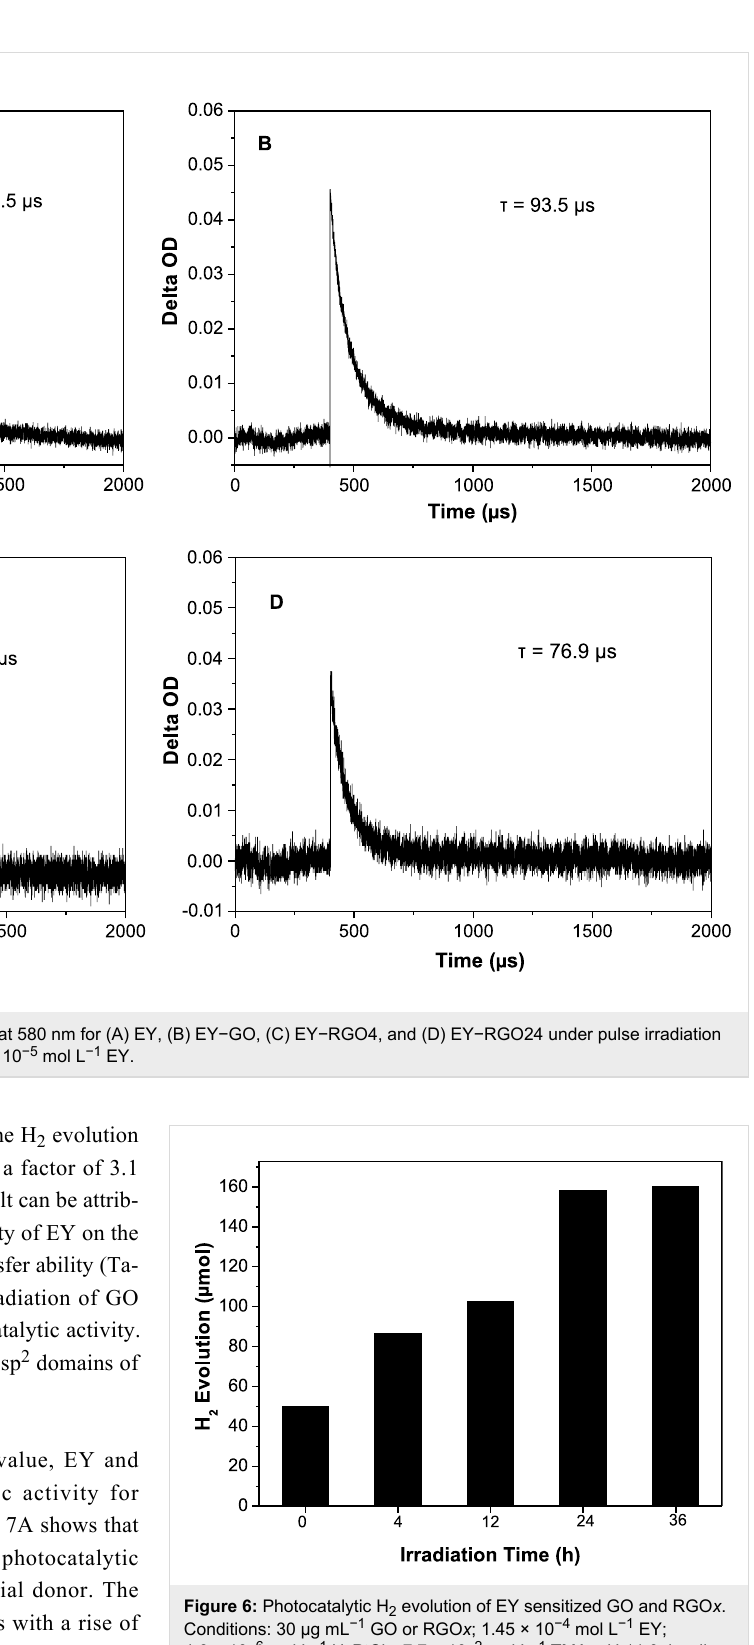
Figure 6: Photocatalytic H 2 evolution of EY sensitized GO and RGO x . Conditions: 30 μ g mL − 1 GO or RGO x ; 1.45 × 10 − 4 mol L − 1